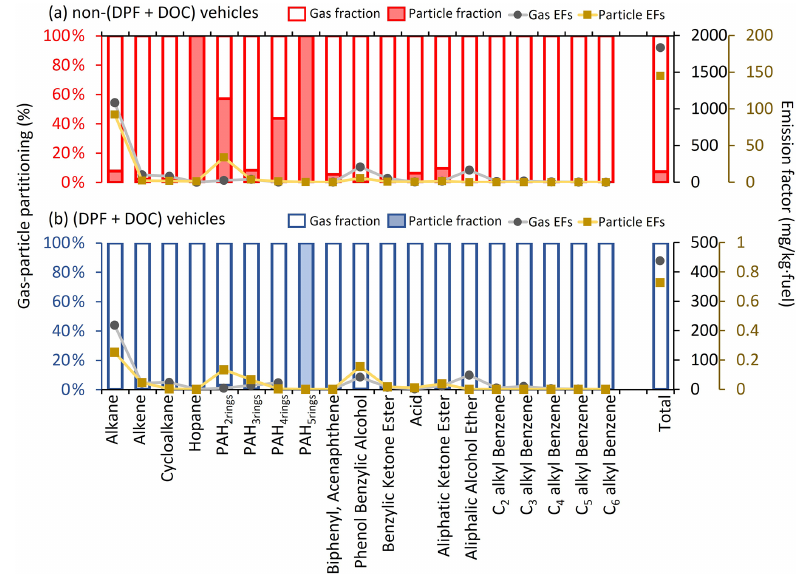
Figure 6. The gas–particle partitioning of speciated I/SVOCs emitted from (a) non-(DPF + DOC) vehicles and (b) (DPF + DOC) vehicles. The hollow and filled columns represent the gas and particle fractions, respectively. The gray dots and brown squares represent the EFs of the gaseous and particulate I/SVOCs, respectively.